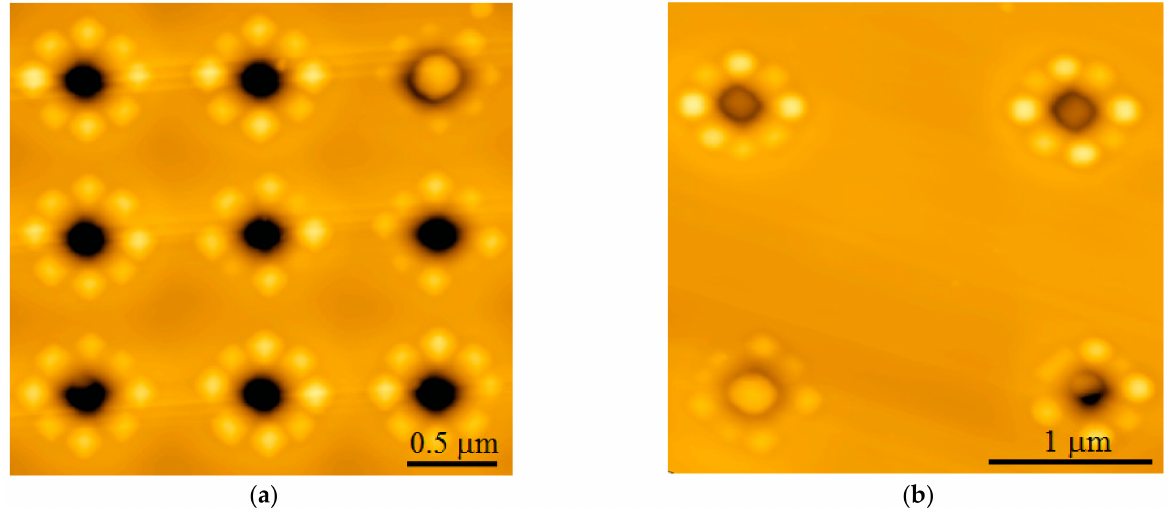
Figure 5. AFM images of the ordered arrays of QDs formed after the deposition of ~4 ML of Ge on patterned SOI substrates with pit periods of 1 µ m ( a ) and 2 µ m ( b ). The color scale of heights is selected in such a way as to highlight the QDs against the